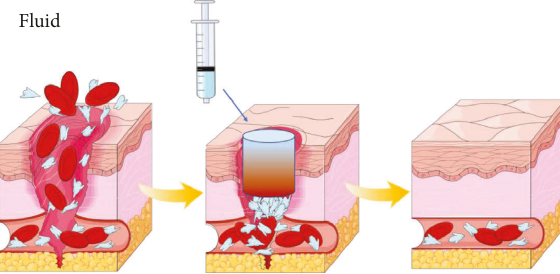
Figure 3: Relying on the high adhesion of the material to closely bind to the damaged tissue and close the wound, while forming a physical barrier, using some components that can promote the aggregation of red blood cells and platelets to accelerate